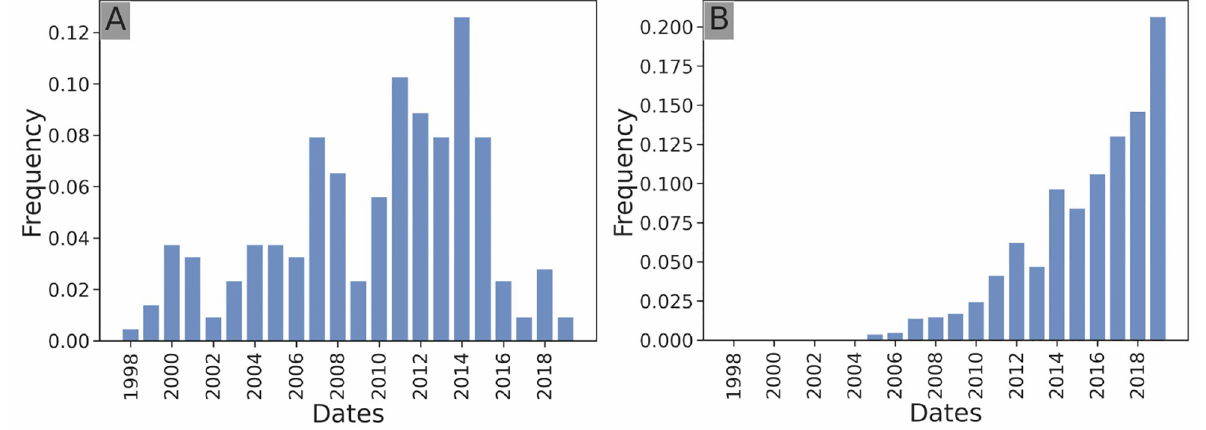
Fig 2. Temporal investment distribution. Temporal investment distribution of Softbank Capital ( A ), a telecom-focused US-based venture capitalist that stopped its activity in 2017, and of Y Combinator ( B ), a US-based startup accelerator founded in 2005. The two temporal patterns of actvitity are quite different between the two structures, as Softbank Capital stops investing near the end of the period whereas Y Combinator’s activity steadily grows throughout the whole period.